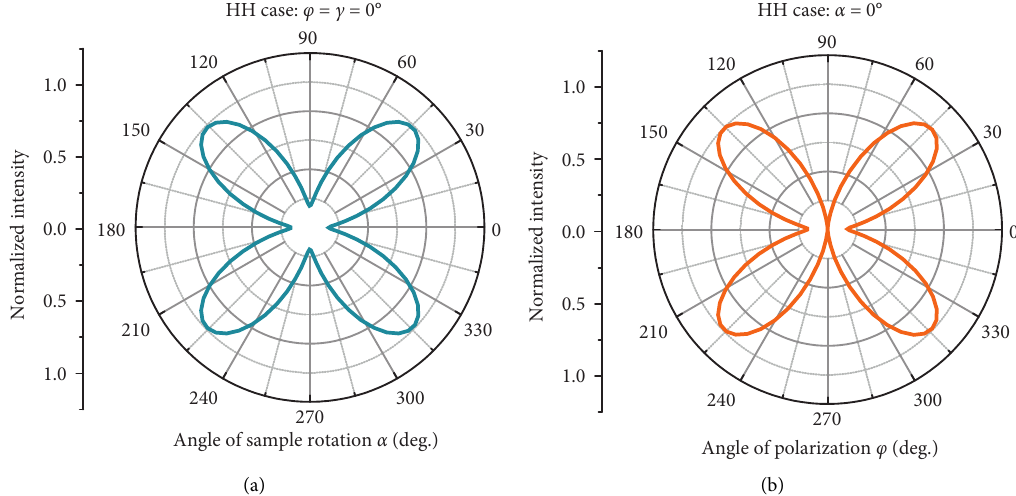
Figure 9: Intensity distributions of Raman modes in the HH case under the oblique backscattering configuration ( β � 30 ° ) for (a) a fixed polarization direction φ � c � 0 ° but a rotated sample rotation angle α and (b) a fixed sample rotation angle α � 0 ° but a rotated polarization direction φ ( c � φ